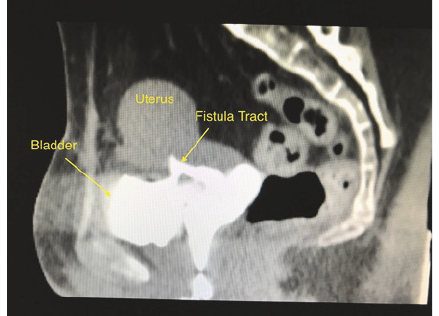
Figure 3: Sagittal view of contrast-enhanced CT scan demonstrat- ing the connection between bladder and uterus.